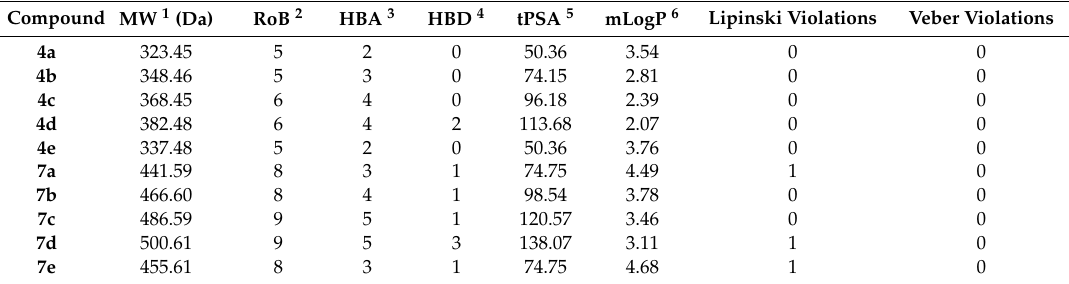
Table 4. Computationally predicted drug-like descriptors of compounds 4a – e and 7a – e . Compound MW 1